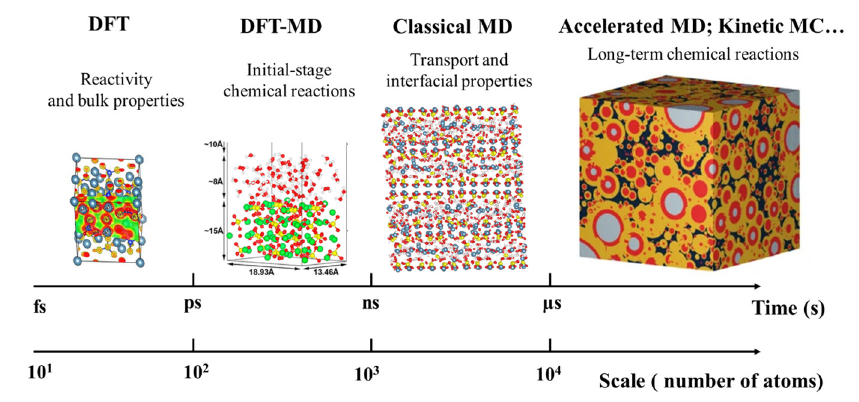
Figure 1. Schematic of atomistic simulation methods in various time and space